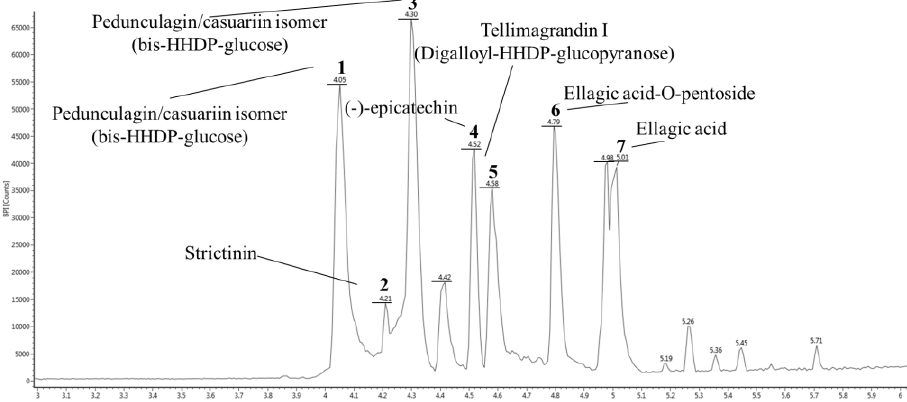
Figure 1. UPLC Q-TOF/MS E chromatography in negative ion mode of ethyl acetate fraction from Gimcheon 1ho (GC) cultivar walnut ( Juglans regia ). Table 2. Identification of main compounds of Gimcheon 1ho (GC) cultivar walnut ( Juglans regia ). Peak